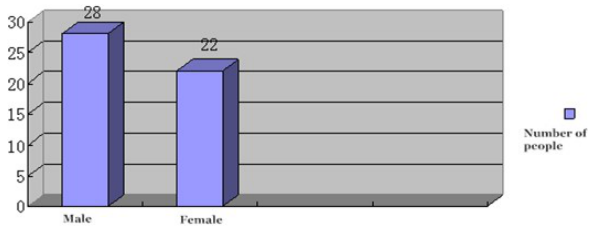
Figure 3-3 Gender statistics of participants in the Shilin Yi' s wrestling